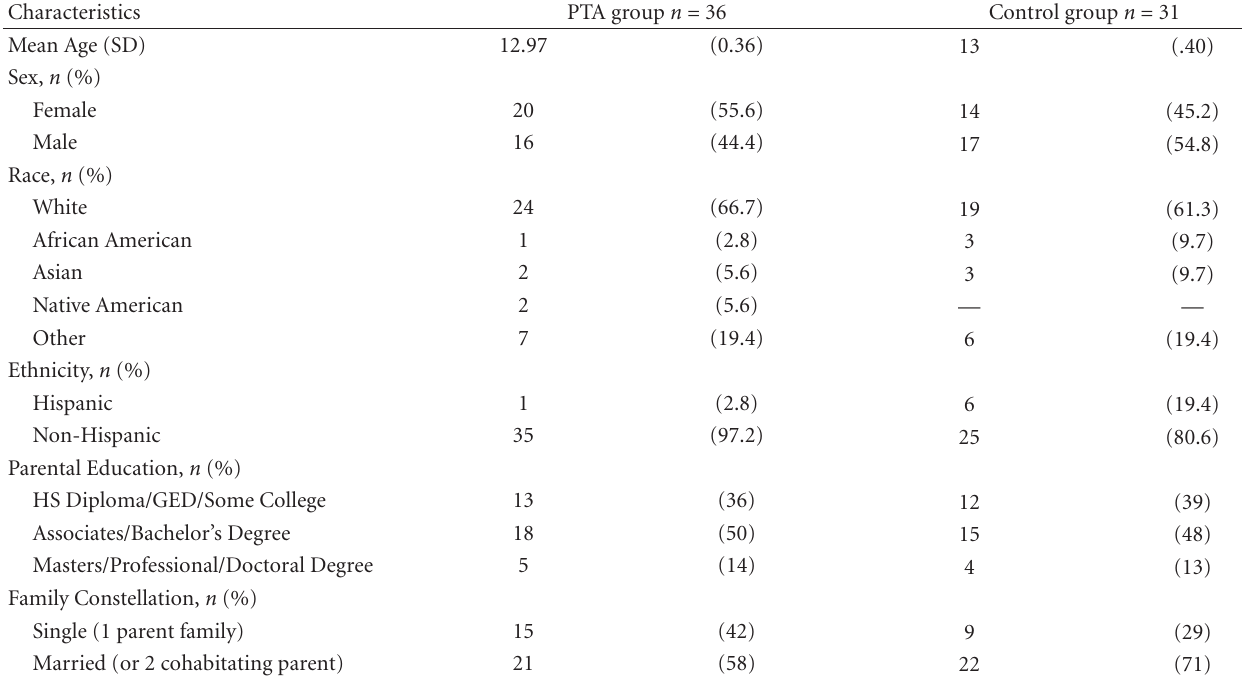
Table 1: Demographic characteristics of